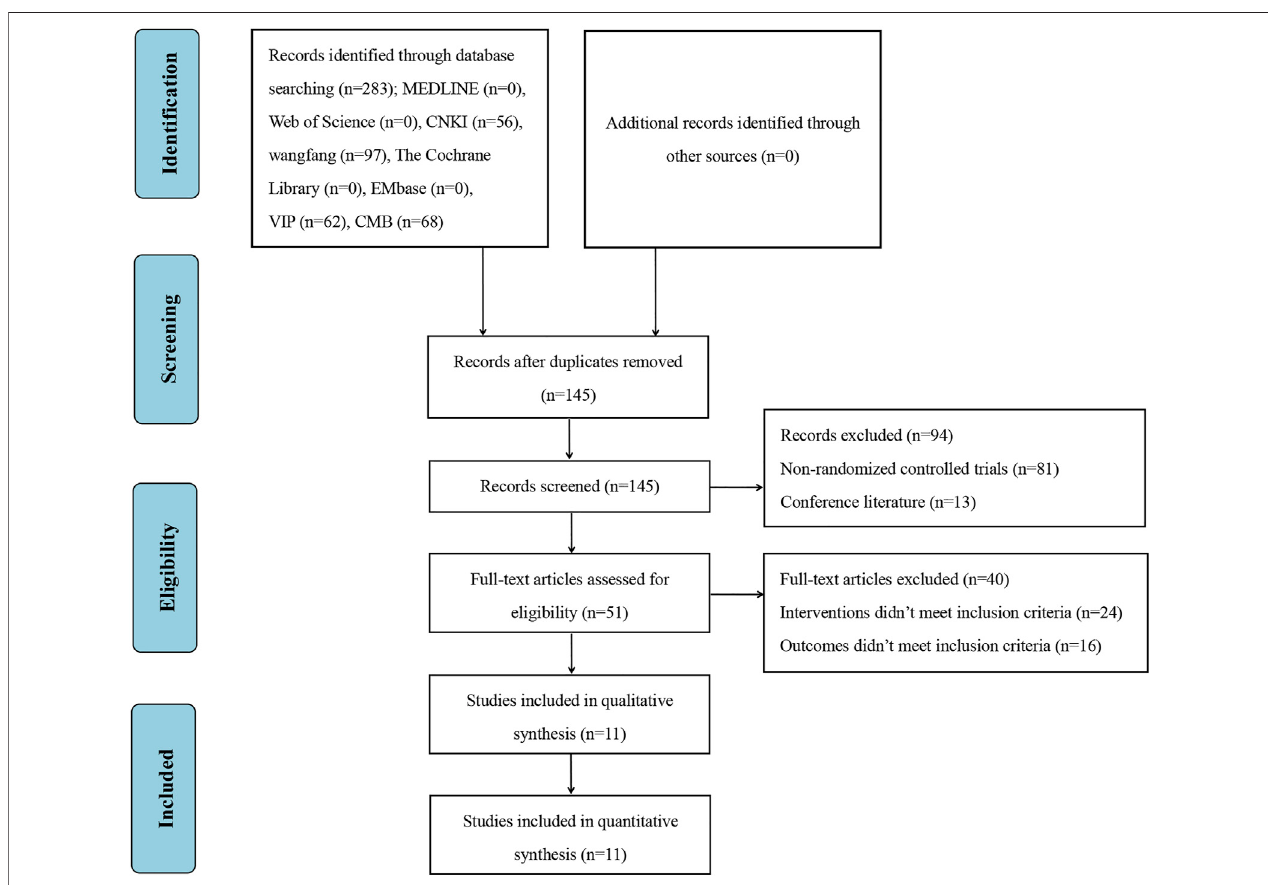
FIGURE 1 | Flow diagram of literature